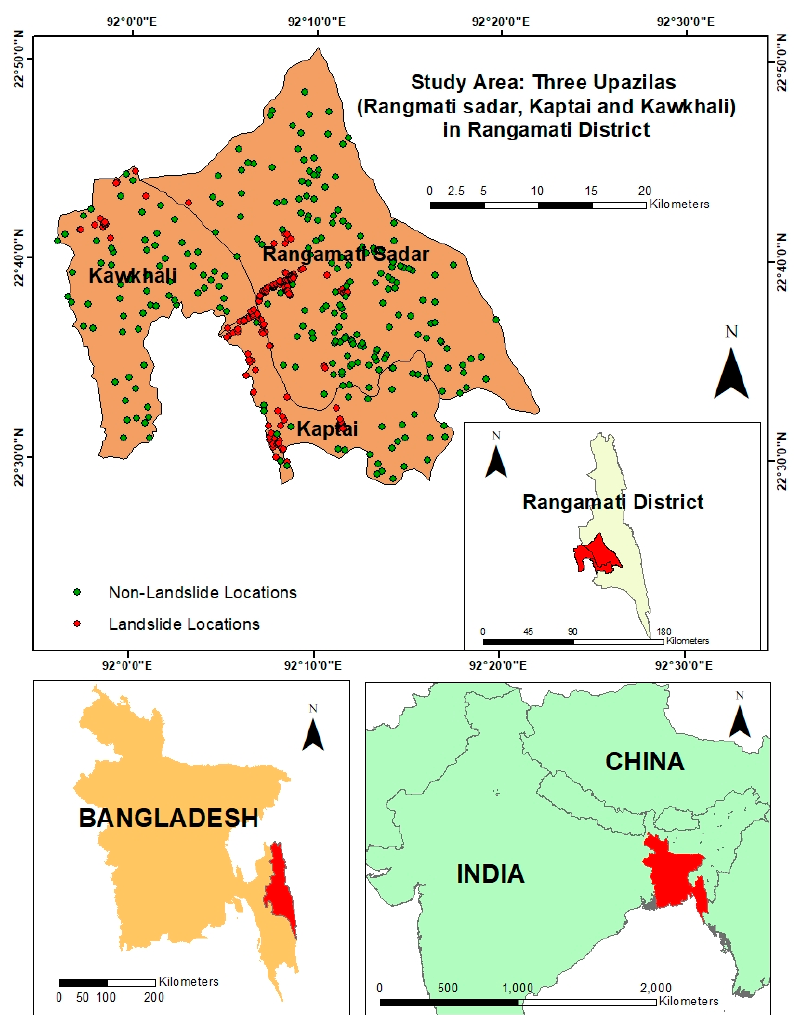
Figure 1. Study area and landslide and non-landslide (pseudo-absence points) locations used in modeling.